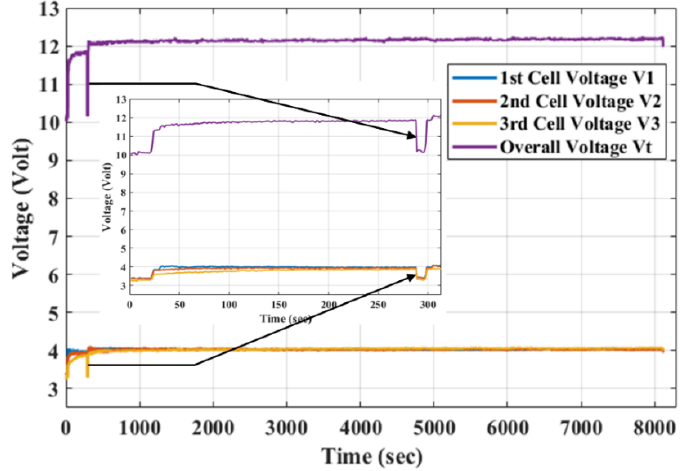
Figure 11. Charging voltage profile of the lithium- ion battery using the proposed technique.